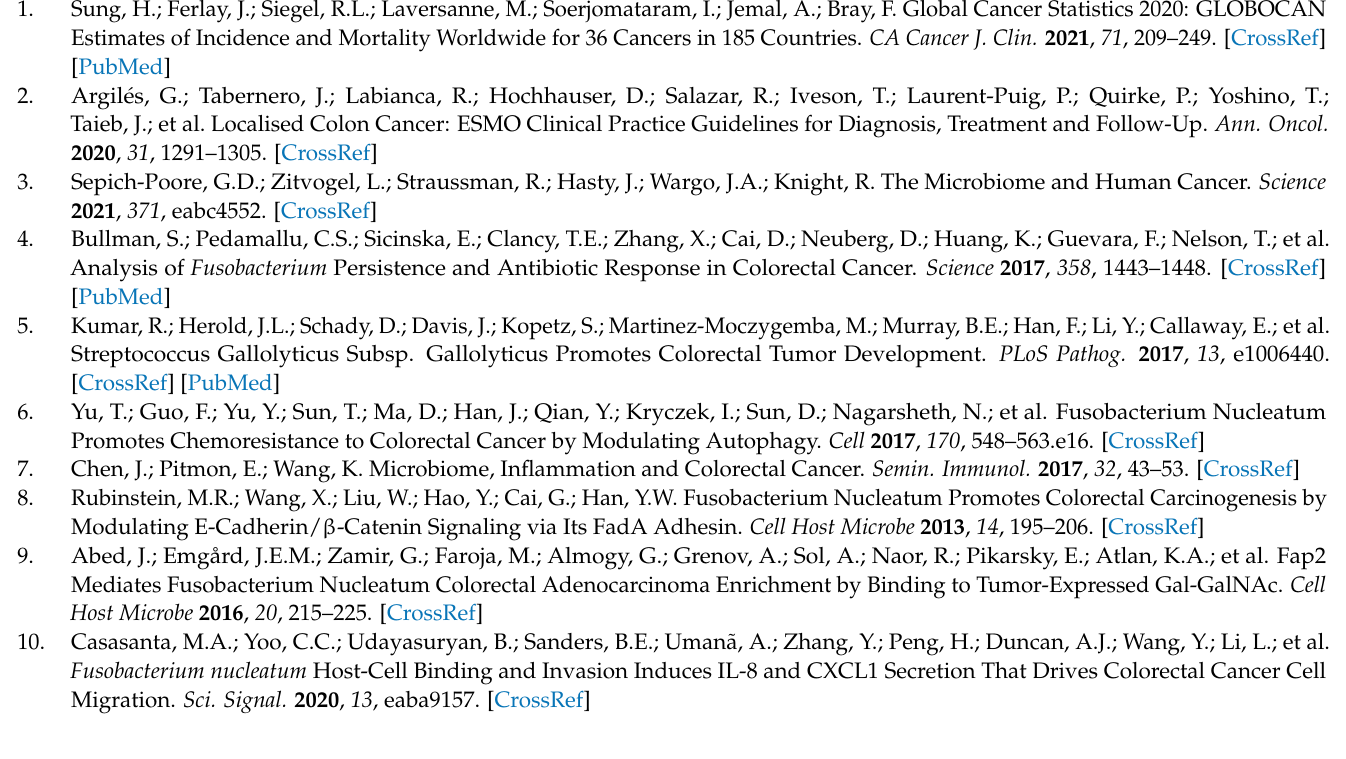
E-cadherin bactoprecipitation by Fn . Figure S3: Forward-scatter gating of live CSCs in flow cytometry studies. Figure S4: Phosphorylation of GSK3 β in response to Fn , but not E. coli , in CSC-pLKO cells. Figure S5: Increased proliferative capacity of CEACAM-1-depleted cells compared with non- targeted controls. Figure S6: RayBio ® C-SeriesHuman Cytokine Antibody Array C3 Map. Figure S7: SHP-2 and SHP-1 expression in CSCs. Figure S8: No evidence for CEACAM-1 phosphorylation on tyrosine in Fn -stimulated CSC-P cells. Figure S9: CEACAM-1 expression level is not modulated by CSC